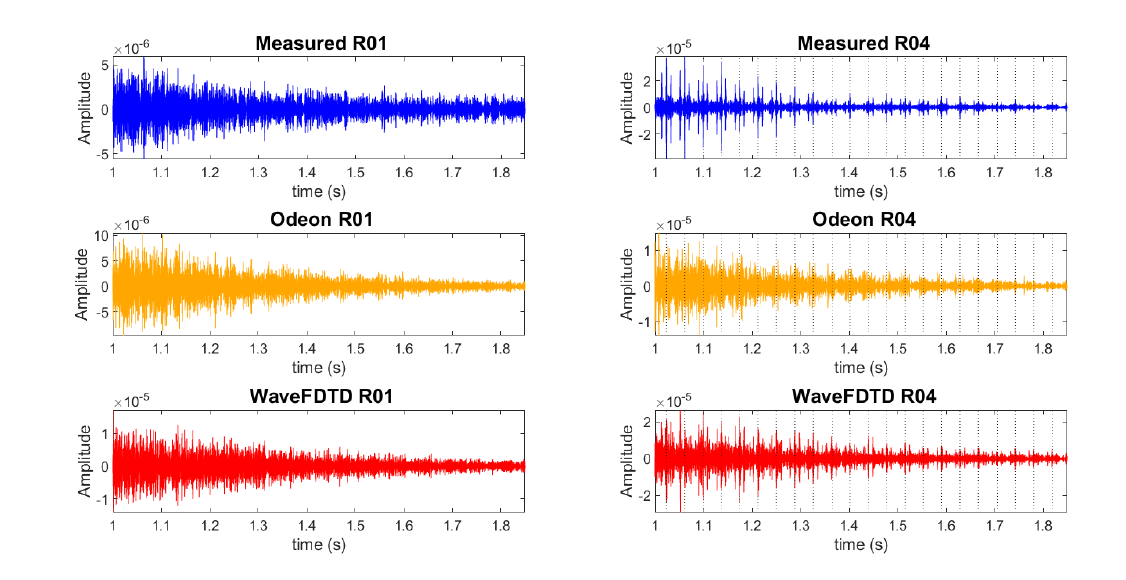
Figure 13. Level 4 MRA of original measured and modeled room impulse response (RIR), R01—in the audience, 3 m from source, R04—on the aisle 3 m from source. Dotted lines identify the middle peak of the triplets in the measured